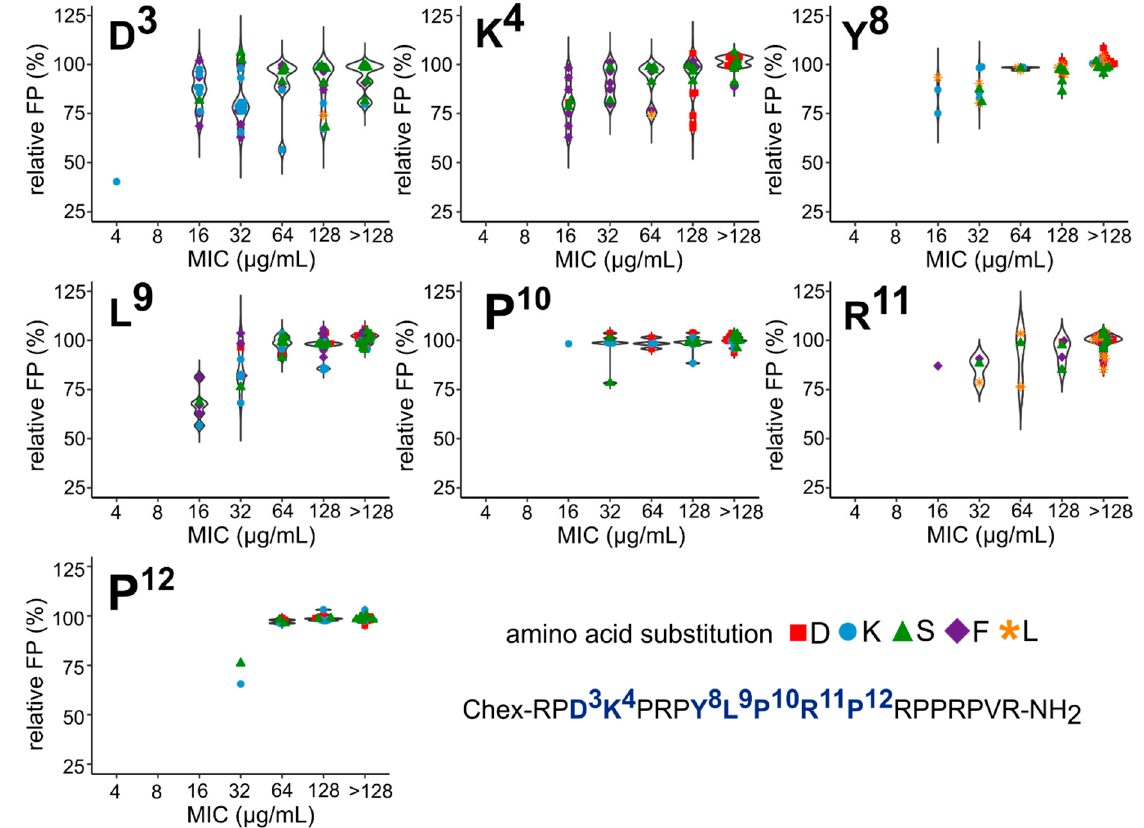
Figure 6. Violin plot illustrating the correlation of relative FP and MIC values for ARV-1502 analogs substituted in the binding motifs D 3 K 4 and Y 8 LPRP 12 with aspartic acid ( ■ ), lysine ( ● ), serine ( ▲ ), phenylalanine ( ) or leucine ( ).